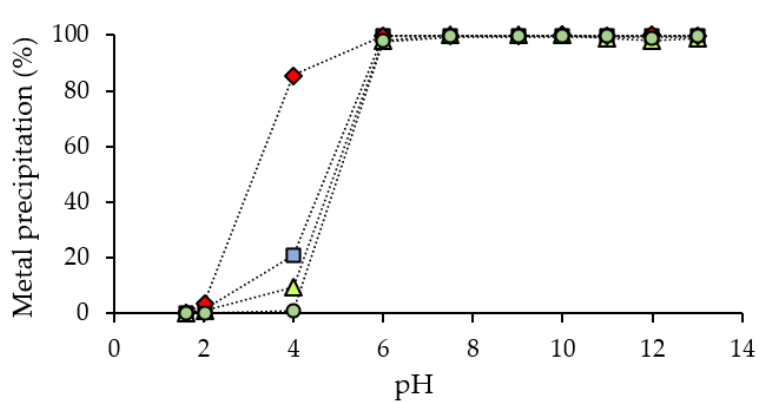
Figure 10. Metal precipitation efficiency (Cu (blue square), Fe (red diamond), Ni (yellow triangle) and Zn (green circle)) when combining NaOH and Na 2 S as precipitant agents.